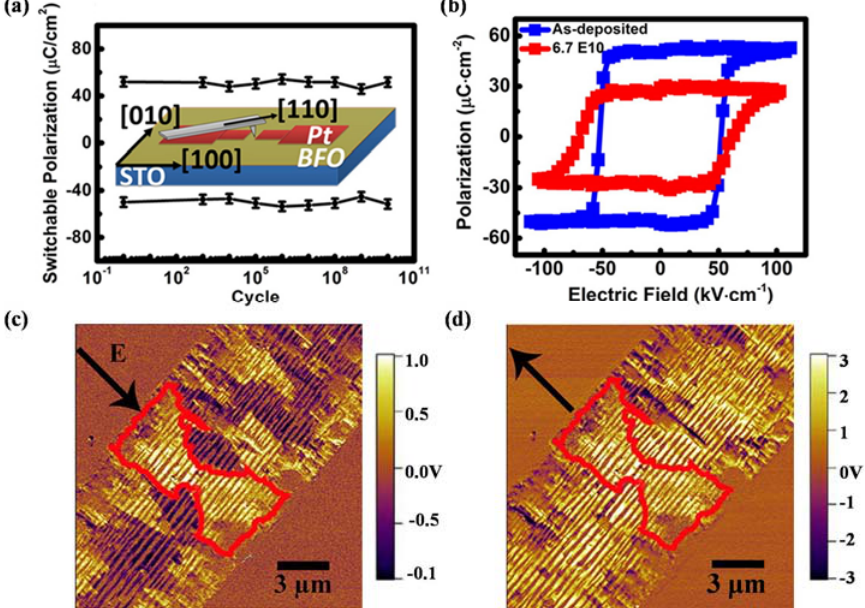
Figure 20. ( a ) Switchable polarization obtained from the remanent hysteresis loops of a planar (001)-oriented BiFeO 3 device shows no fatigue up to 10 10 cycles, with the inset showing the planar device configuration; ( b ) fatigue of BiFeO 3 : remanent hysteresis loops indicate reduction of switchable polarization after 6.7 × 10 10 cycles; ( c , d ) IP-PFM images which demonstrate domain pinning across the channel (red outline). (Zou et al.